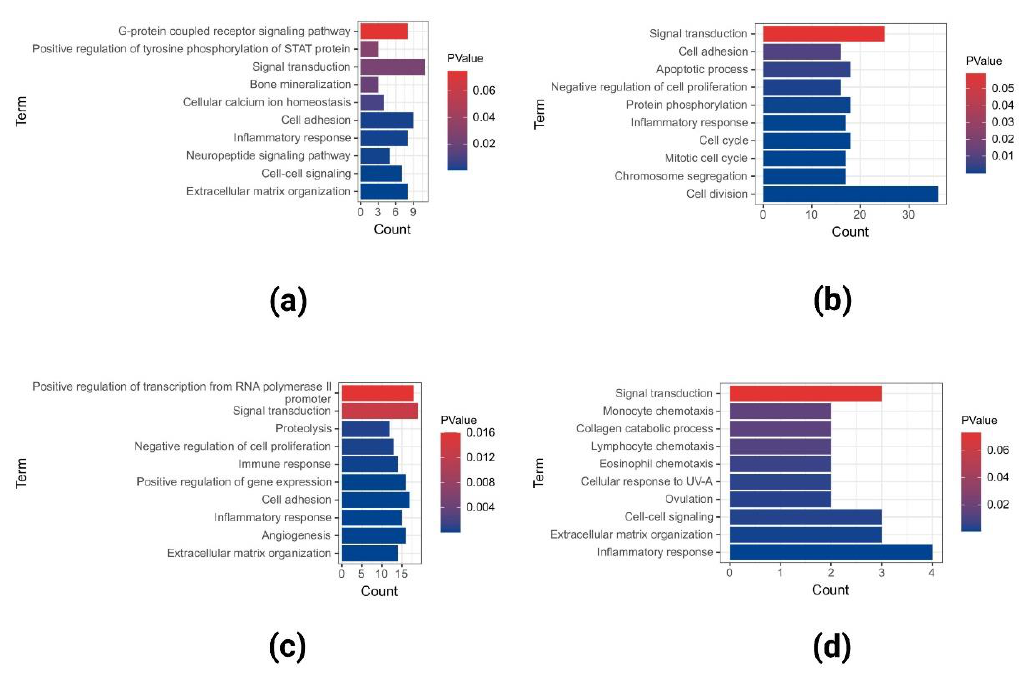
Figure 4. GO analyses of upregulated DEGs in GSE40290 ( a ), GSE61218 ( b ), GSE53819 ( c ), and co-upregulated DEGs ( d ) in the three datasets.